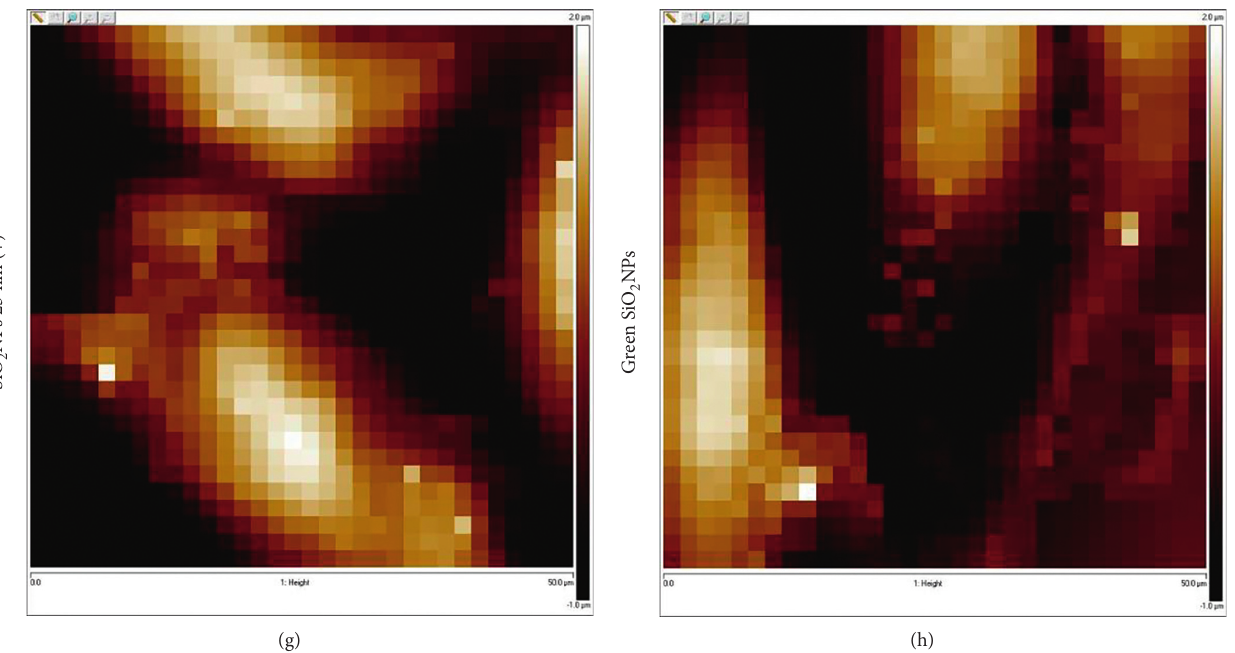
Figure 13: Representative AFM height channel acquisitions performed in force-volume mode on living A549 cells (a) and cells exposed to 5mg/mL of SiO 2 NPs 110nm ( − ) (b), SiO 2 NPs 110nm (+) (c), SiO 2 NPs 50nm ( − ) (d), SiO 2 NPs 50nm (+) (e), SiO 2 NPs 25nm ( − ) (f), SiO 2 NPs 25nm (+) (g), and green SiO 2 NPs (h) for